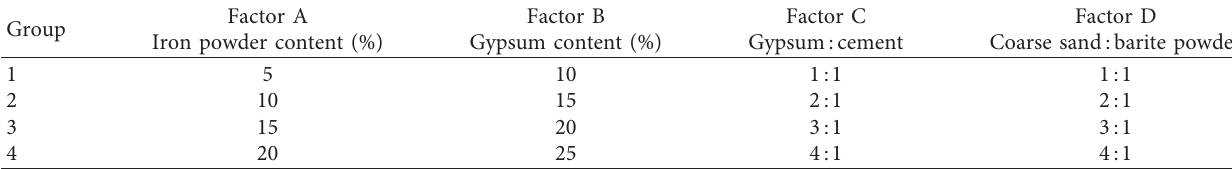
Table 2: Orthogonal design of similar materials.